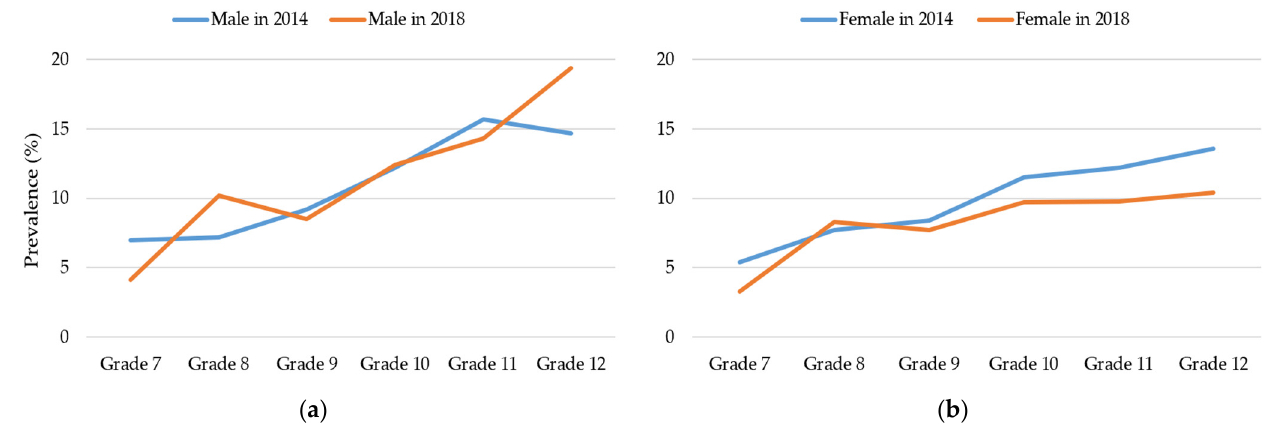
Figure 3. Substance use and misuse in male ( a ) and female ( b ) students by grade in 2014 and 2018. Table 3. Factors associated with past 30-day substance use in 2018 ( n =